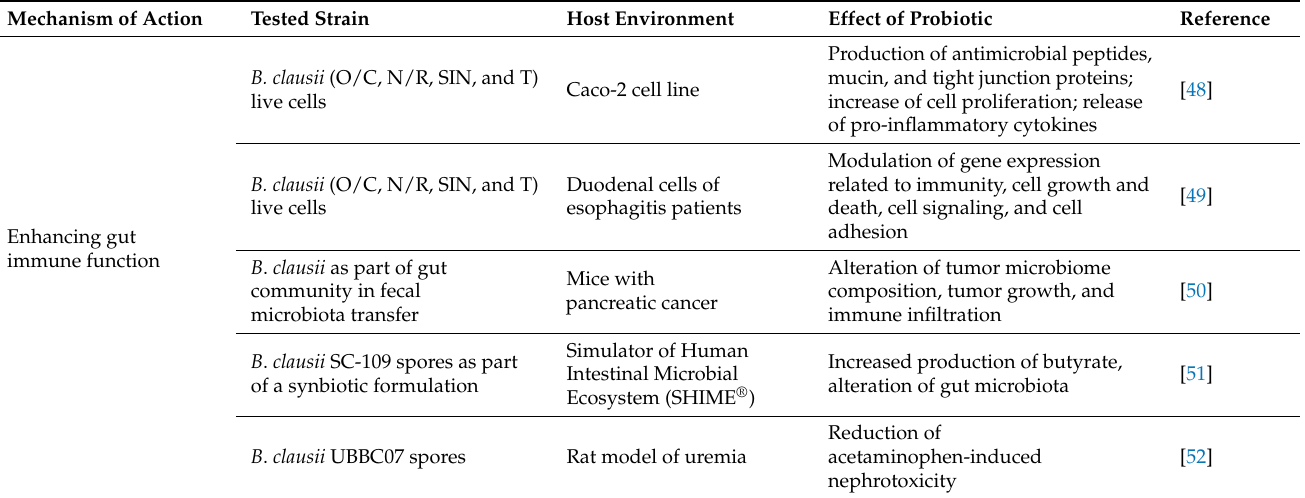
Table 2. Mechanisms of action of B . clausii probiotics identified through preclinical